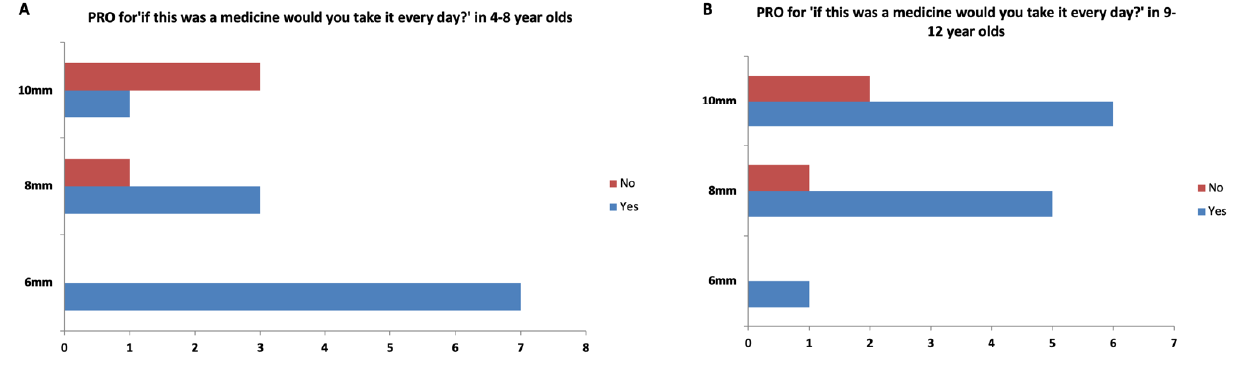
Figure 7. PRO score for ‘if this was a medicine would you take it every day?’ in ( A ) 4–8-year-olds, and ( B ) 9–12 years old, ( C ) Which tablet felt better in the mouth? (Researcher question), and ( D ) ‘Which tablet felt better in the mouth?’ for participants aged 4–8 and 9–12 years. 4. Discussion To our knowledge, this is the first study to report the administration of ingestible 3D printed tablets to CYP. In doing so, this study moved into new territory and explored the regulatory framework for conducting studies using 3DP non-GMP tablets in children. In addition, 86.7% of participants successfully swallowed the 3DP tablet they attempted to take compared to 91.5% for CAT study tablets. Attributes of the 3D printed tablets were scored as acceptable by the following percentage of participants swallowability (80%), mouthfeel/texture (87%), the volume of water required (80%), acceptability (83%), and taste (93%). Furthermore, 77% of children advised they would be happy to take the tablet every day if it were a medicine. The data demonstrate that 3D printed SDFs, particularly 6-mm, are an acceptable option for CYP aged 4–12 years. Although the size of the sample is limited, the study also provides a comparison of the potential overall acceptability of tablets fabricated by this emerging technology in comparison to conventionally manufactured bi-convex tablets. The size of the tablets used in this study conforms to those of conventionally sized tablets, rather than minitablets. The literature has shown that training can help children to swallow tablets of larger size than minitablets [22,23]. All the participants in this study had already demonstrated an ability to swallow a film-coated tablet in the size and shape tested in this study. Only 4 out of the 30 participants could not swallow the larger size tablets (8 and 10 mm). The difficulty of swallowing 3D printed tablets could potentially stem from the presence of layers in the tablet structure. This could result in the formation of a rougher tablet surface. Another possible contribution to the difference of the 3D printed tablets compared to the film-coated ones stems from the composition of the tablet. In this study, there were no reports that the taste of 3DP tablets was a barrier to ac- ceptability. In this instance, methacrylate polymer has been used. It is widely used for film coating for taste masking. Eudragit E, a cationic co-polymer based on diethylaminomethyl methacrylate and neutral methacrylic esters, has been designed as a coating taste-masking